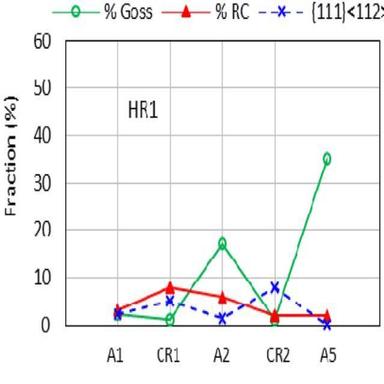
Evolution of the main texture components during the thermo-mechanical processing of the hot-rolled sheet (a) HR1 and (b) HR6.